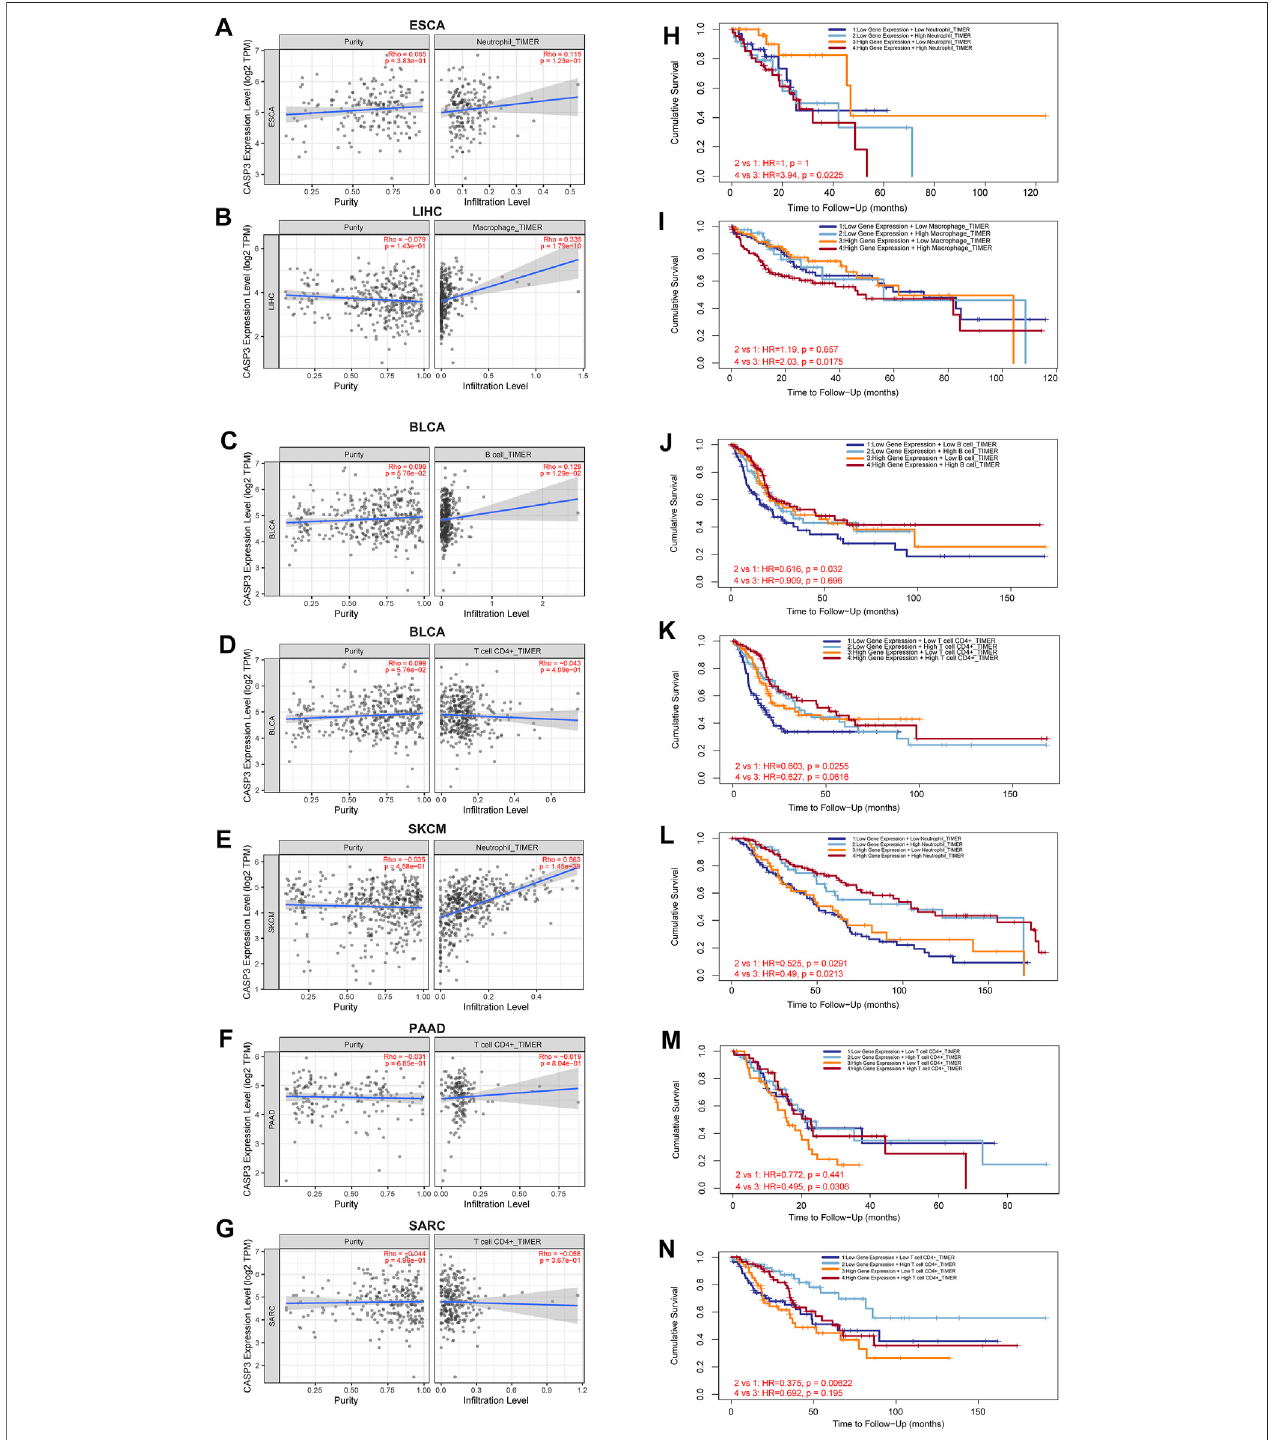
FIGURE 10 | Relationship between CASP3 expression and tumour immune cell in fi ltration. (A – G) the expression of CASP3 in ESCA, LIHC, BLCA, skin cutaneous melanoma (SKCM), PAAD, SARC and its relationship with immune cell in fi ltration. (H – N) Kaplan-Meier survival analysis of CASP3 expression and the relationship between immune in fi ltration and OS of ESCA, LIHC, BLCA, SKCM, PAAD, SARC.